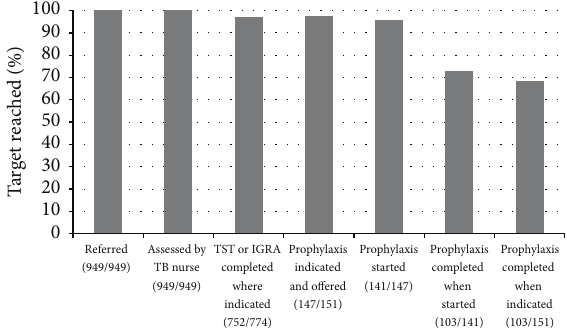
Figure 2: Cascade of care for refugees referred and followed at the New Canadians